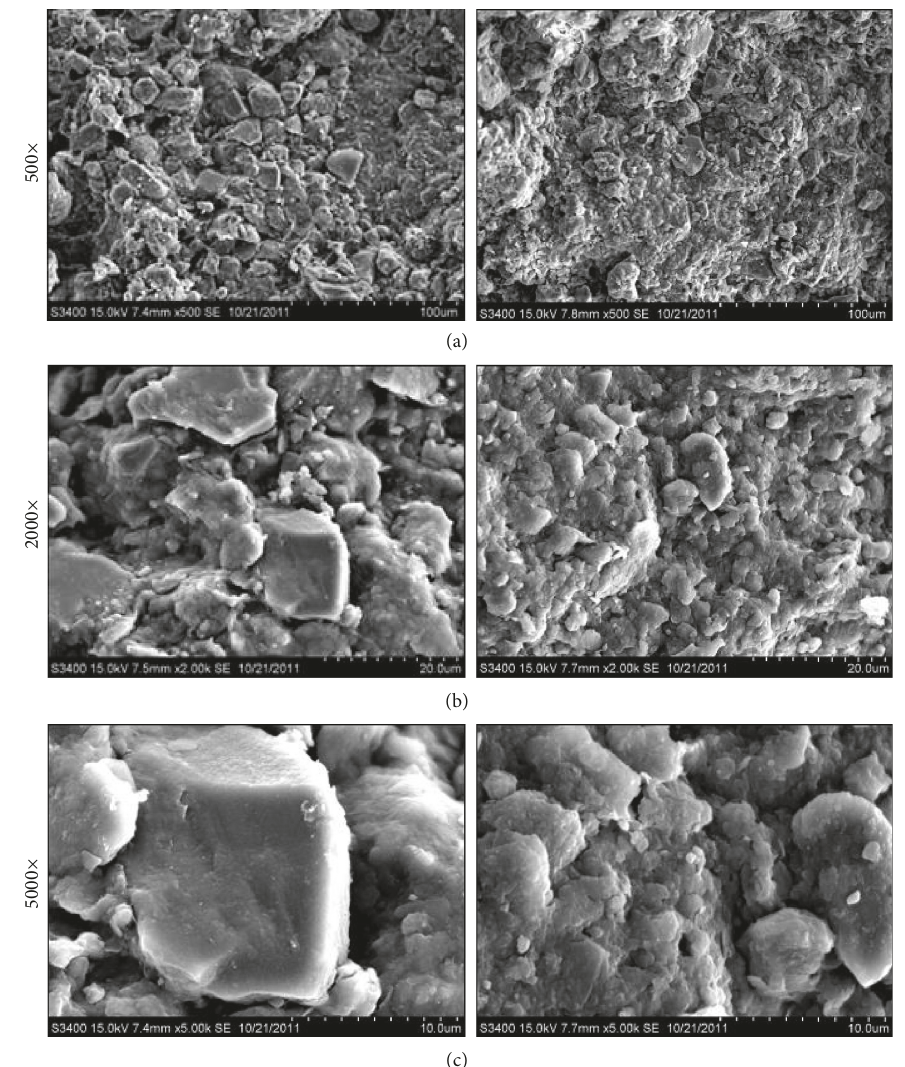
Figure 10: SEM micrographs of the samples with and without stabilization. Note: the SEM images were taken in